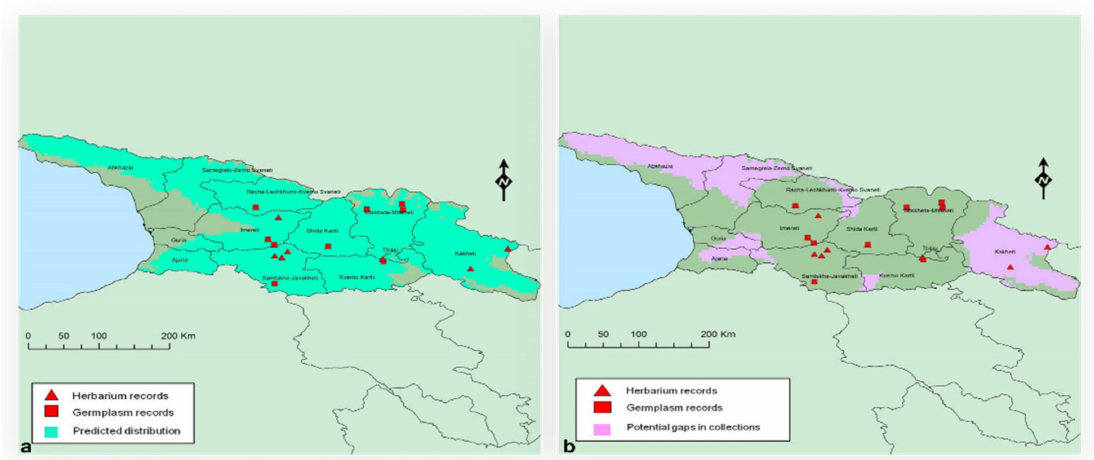
Figure 6. Example of distribution and target maps provided in the Crop Wild Relative (CWR) Collecting Guides. ( a ) Predicted distribution of Malus orientalis in Georgia based on herbarium and existing germplasm records. The bright green shaded area, showing the predicted distribution, was modeled using known localities, which are also plotted on the map. ( b ) Target collecting areas (potential gaps) in ex situ collections of Malus orientalis. The pink shaded areas highlight areas in the predicted distribution from which no germplasm had yet been collected, indicating where seed collections would be targeted by the CWR